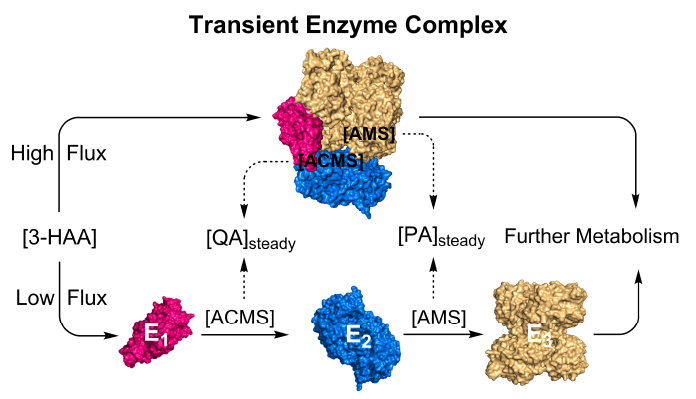
Figure 5. Illustrated hypothesis: formation of substrate-induced transient enzyme complex at high metabolic fl ux for regulating non-enzymatic reactions. E 1 : HAO, E 2 : ACMSD, and E 3 : AMSDH. metabolic flux for regulating non-enzymatic reactions. E 1 : HAO, E 2 : ACMSD, and E 3 :